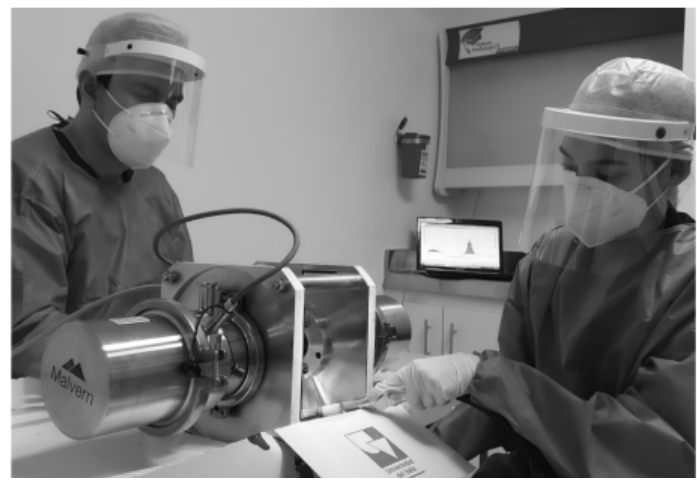
Figure A2. The experimental setting with the clinician in the left side of the image, the measurement device, Insitec S (Malvern Panalytical Ltd., Malvern, UK) in the middle, the dental assistant holding the high-volume evacuator in the right and the real-time analytical computer equipment in the